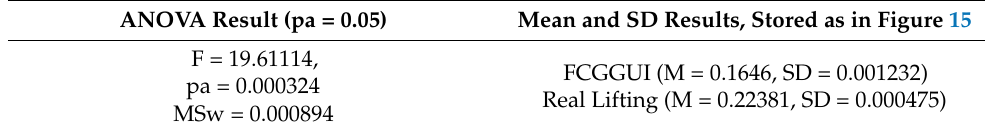
Table 12. Results of the ANOVA test of the exert force in Experiment